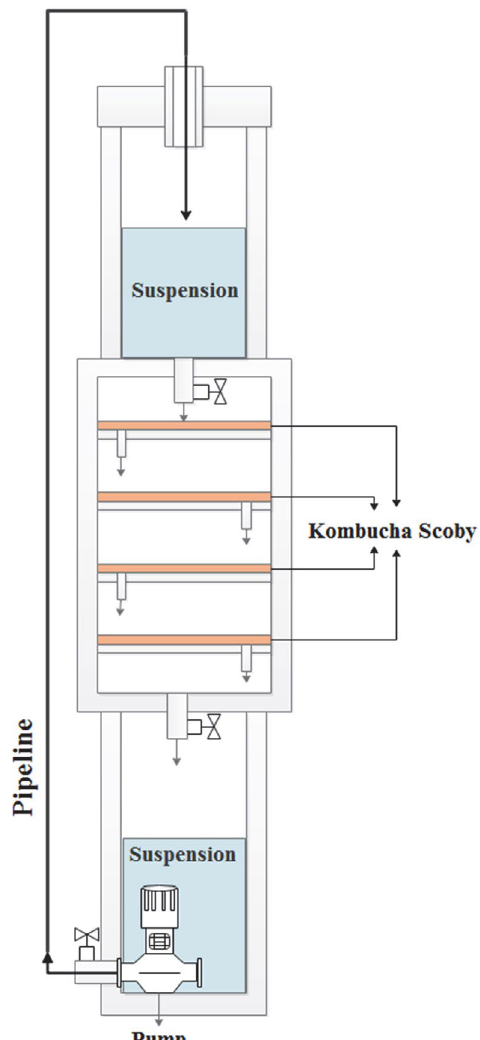
Figure 1. Schematic of experimental setup for reactor